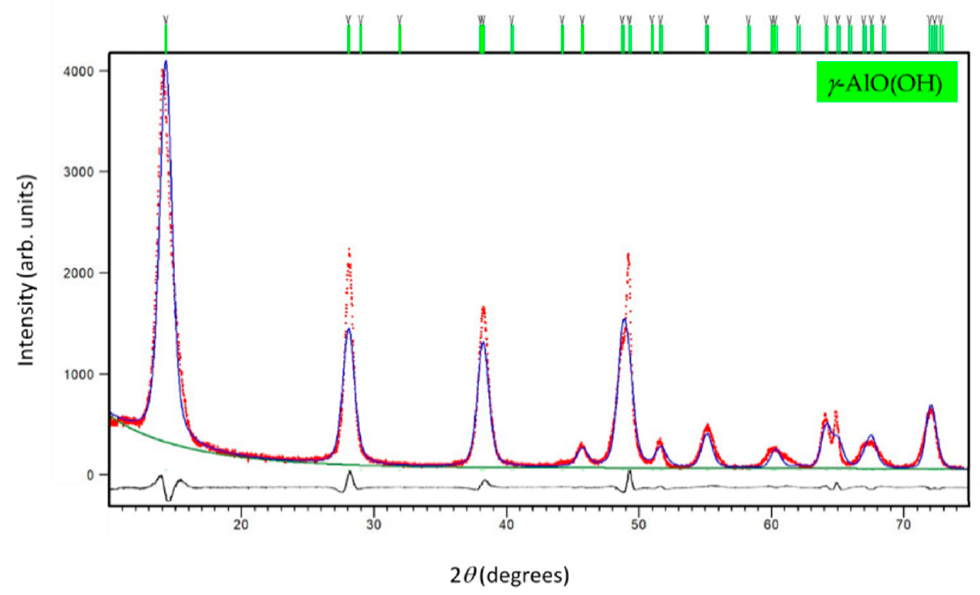
Figure 2. The final observed (red dots), calculated (blue solid line), and difference (black solid line) PXRD profiles of boehmite NPs at RT. The fitted background contribution is represented by the lower green solid line. The upper green tick marks show the reflection positions of the orthorhombic γ -AlO(OH) phase.